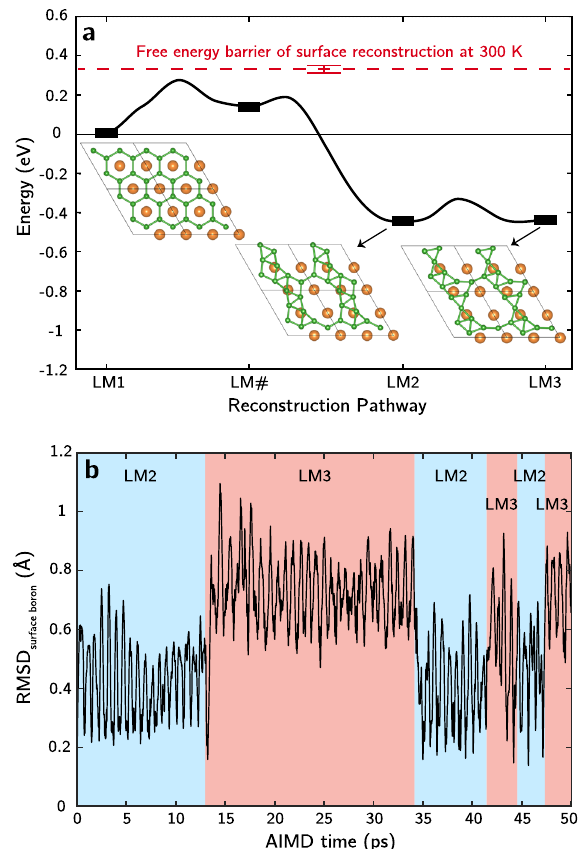
Fig. 2 Surface boron dynamics. a CI-NEB-computed minimum energy paths for LM1 → LM2 → LM3 conversion (black curve), along with the metadynamics-computed free energy barrier for LM1 → LM2 at 300 K (dashed red line, with error bars shown that were determined based on three replicated simulations). Atom color codes: green: B, orange: Mg. b Root mean squared displacement (RMSD) of B surface atoms from AIMD simulations of LM2 at 300 K, referenced to relaxed LM2